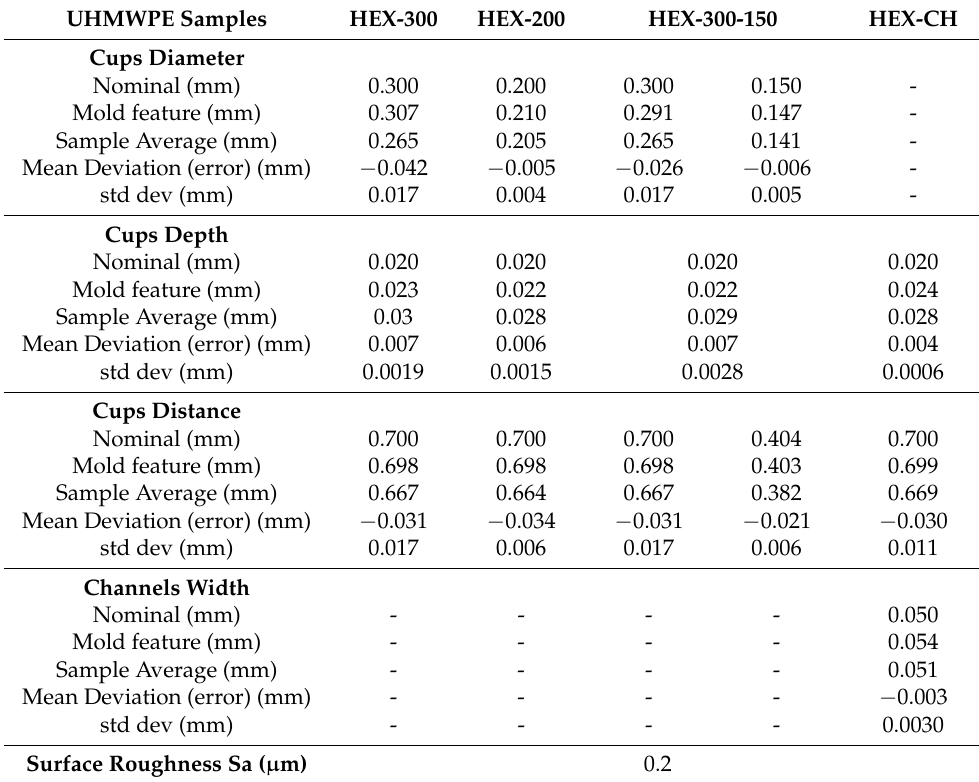
Figure 11. UHMWPE sample: ( a ) HEX-300; ( b ) HEX-200; ( c ) HEX-300-150; ( d ) HEX-300+CH. Figures 12 and 13 show the summary of the percentage errors calculated as the dif- Table 8. UHMWPE sample features’ ference between the molded samples and mold dimensions using values of Tables 5, 7 and 8. The formula used is the following: